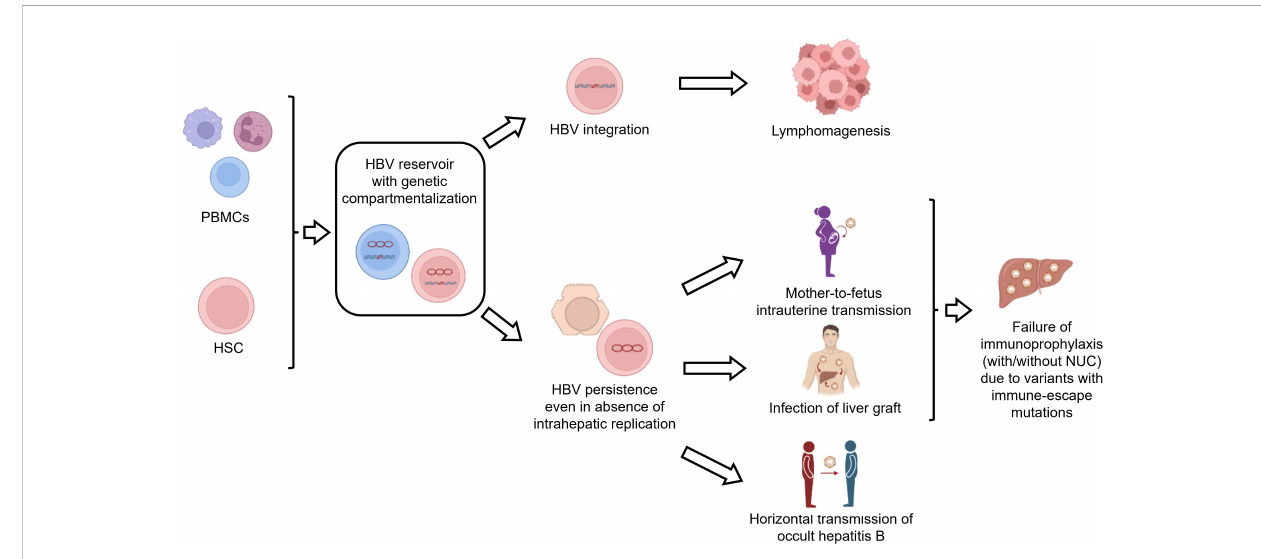
FIGURE 3 Consequences of HBV infection in lymphoid cells. The fi gure summarizes the implications of HBV infection in lymphoid cells. HBV-infected lymphoid cells can act as a reservoir of HBV infection. In particular, HBV persistence in lymphoid cells can contribute to i) the infection of the liver graft after liver transplantation, ii) intrauterine HBV transmission and iii) horizontal transmission of occult HBV infection. Furthermore, integrated HBV DNA can promote lymphomagenesis. Finally, the compartmentalization of viral variants with immune-escape mutations in PBMCs can contribute to the failure of vaccination or immunoglobulin